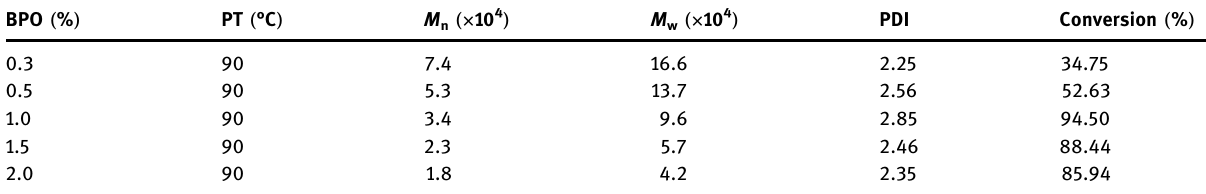
Table 2: E ff ect of di ff erent BPO contents on the MW and MW distribution of PS in LDPE/PS interpolymer resin particles BPO ( %